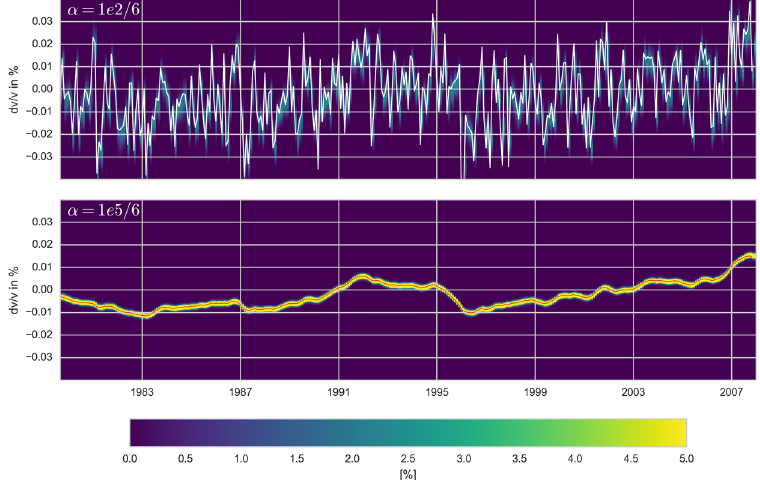
Figure 10. Inversion results using a bootstrap procedure. The color scale shows the percentage of spectra that fall into the dv/v pixel. The value computed with α = 100 (top) or 100 000 (bottom) for the complete dataset (6 pairs) are shown in white (top) or red (bottom). The use of a smaller (larger) α value induces a lighter (stronger) smoothing.